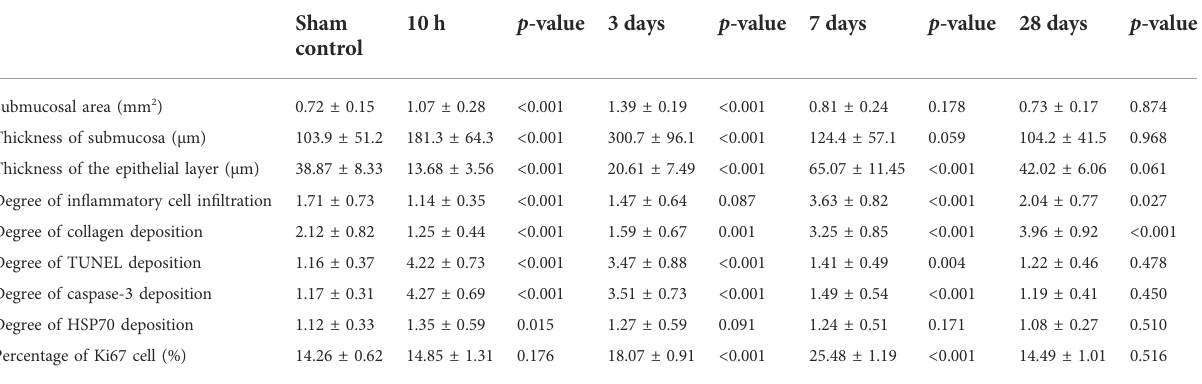
TABLE 1 Histological fi ndings after stent-directed IRE ablation in the rat esophagus. Sham